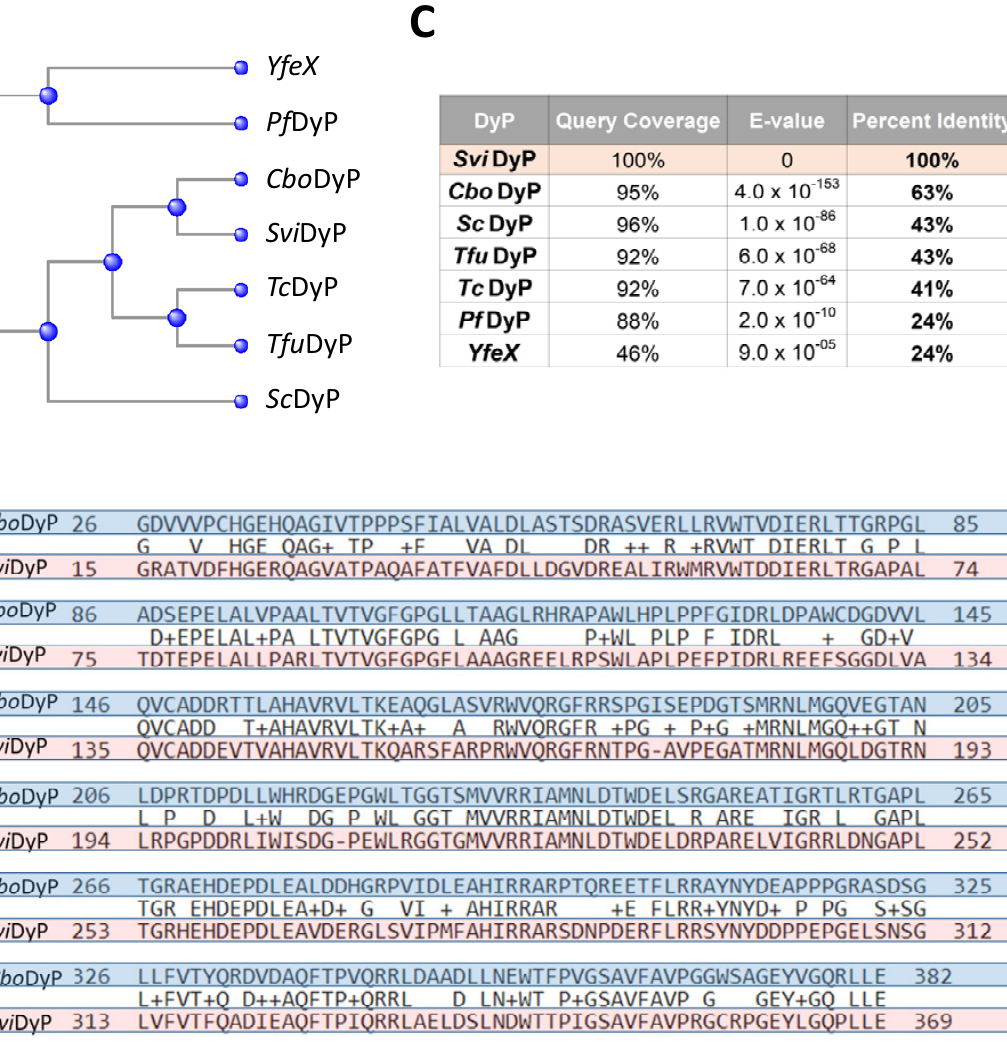
Figure 1. ( A ) Multiple sequence alignments of seven bacterial DyPs obtained using Vector NTI. Cbo DyP, Svi DyP, Tc DyP, Tfu DyP are A-type DyPs and Sc DyP, Pf DyP B2 and Yfe X are B-type DyPs. Residues in the alignment are colored according to the following scheme: Black on white = non-similar to other residues at that position. Blue on cyan = residues that are conserved in the majority of the DyPs at that position. Black on green = similar amino acids. Red on yellow = identical residues at that position. Green on black = residues that are weakly similar. Shown in the alignment as well is the conserved DyP motif “GXX(D/E)G” at position 276–280. ( B ) Phylogenetic tree of the seven rDyPs. ( C ) Sequence similarity analysis based on multiple sequence alignment for 7 DyPs, with 6 different DyPs compared with Svi DyP. Percent identity represents the percentage of amino acids that match up in the alignment and “Query coverage” shows the percentage sequence length that was included in the alignment analysis. ( D ) Sequence alignment of Svi DyP and Cbo DyP showing the similar amino acids between the two